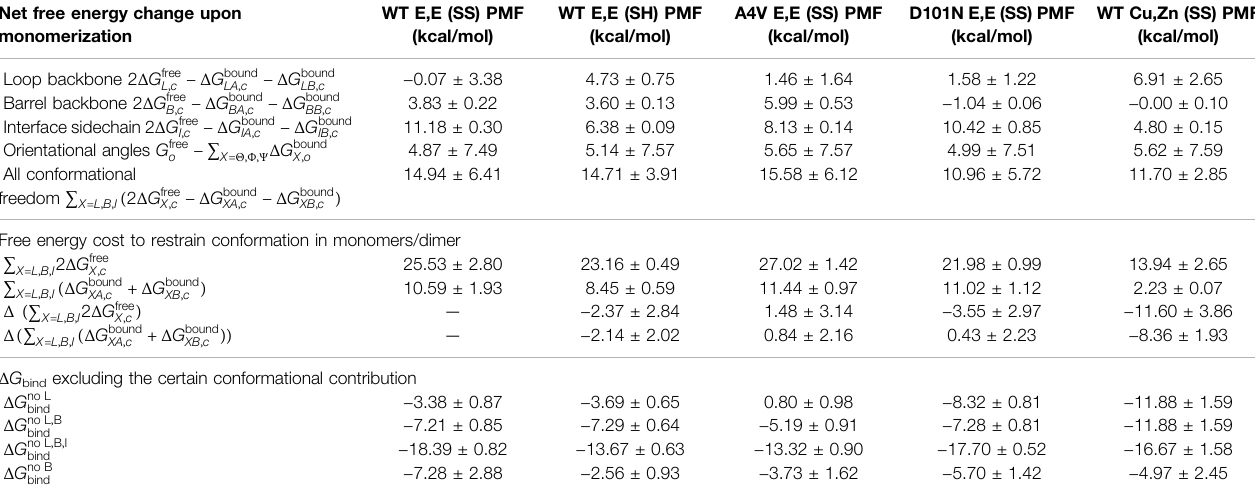
TABLE 6 | Grouping of values in Table 1 in different combinations. Top: the net free energy change of different conformational freedoms upon monomerization. This grouping is used in Eq. 4 . Middle 4 rows: the conformational free energy contributions to dimer and monomers. The free energy changes ΔΔ G compared with WT E,E (SS) are also calculated. Bottom 4 rows: the dimer binding free energies excluding the contributions from loops (row 1), excluding loops and barrel (row 2), excluding loops, barrel, and interface (row 3), and excluding barrel only (after constrained loops; row 4). Net free energy change upon WT E,E (SS) PMF monomerization